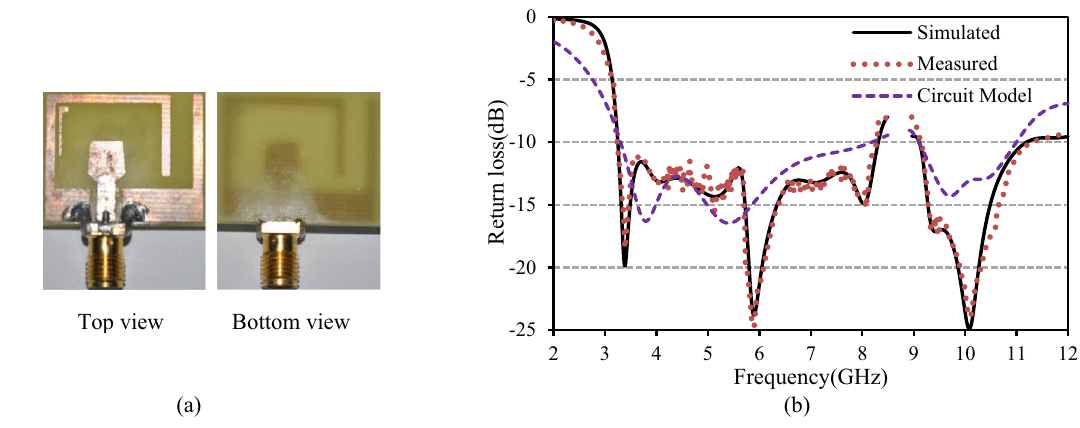
Figure 7. ( a ) Prototype of the designed antenna, ( b ) comparison of return losses versus frequency.